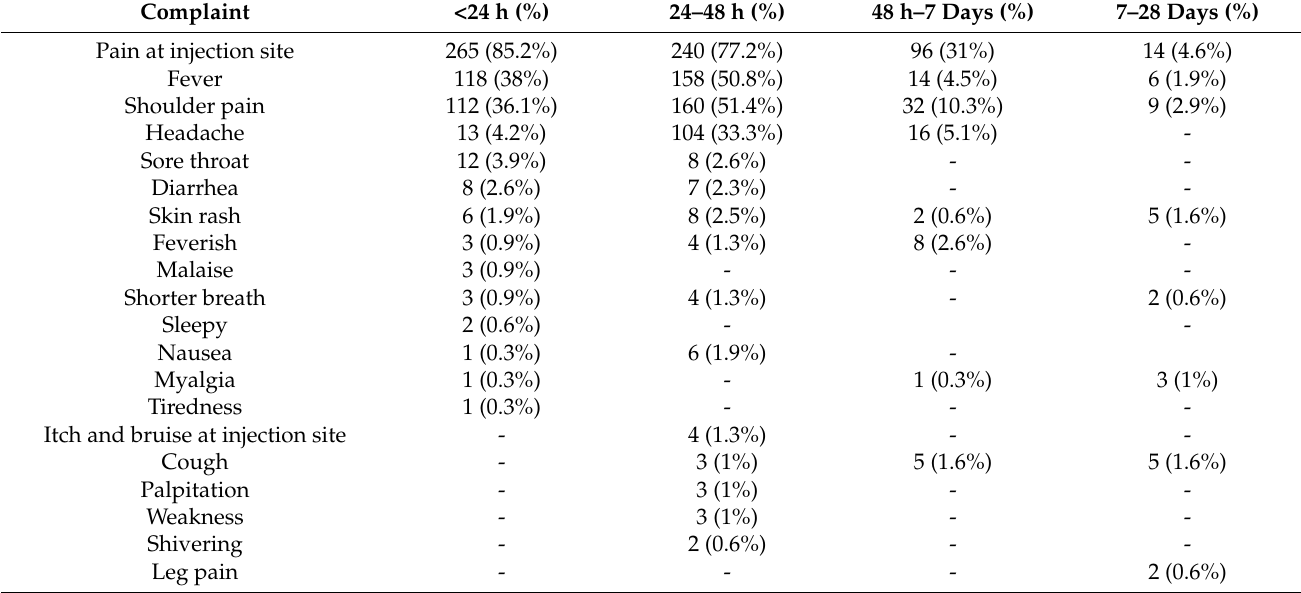
Table 2. Complaints after booster